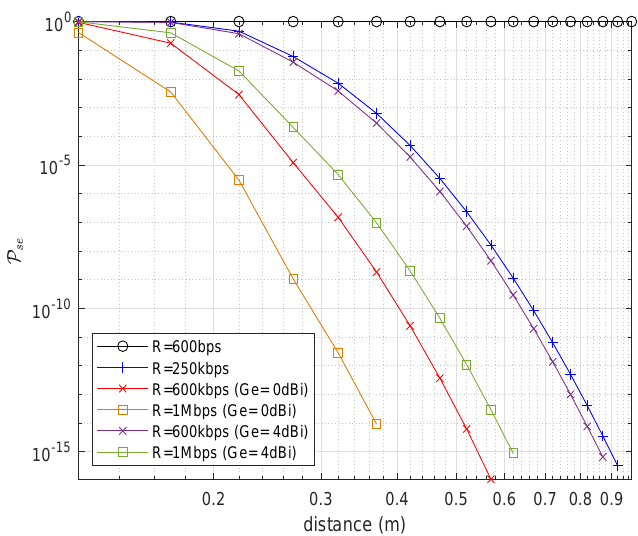
Figure 16. Probability of successful eavesdropping w.r.t Eve distance